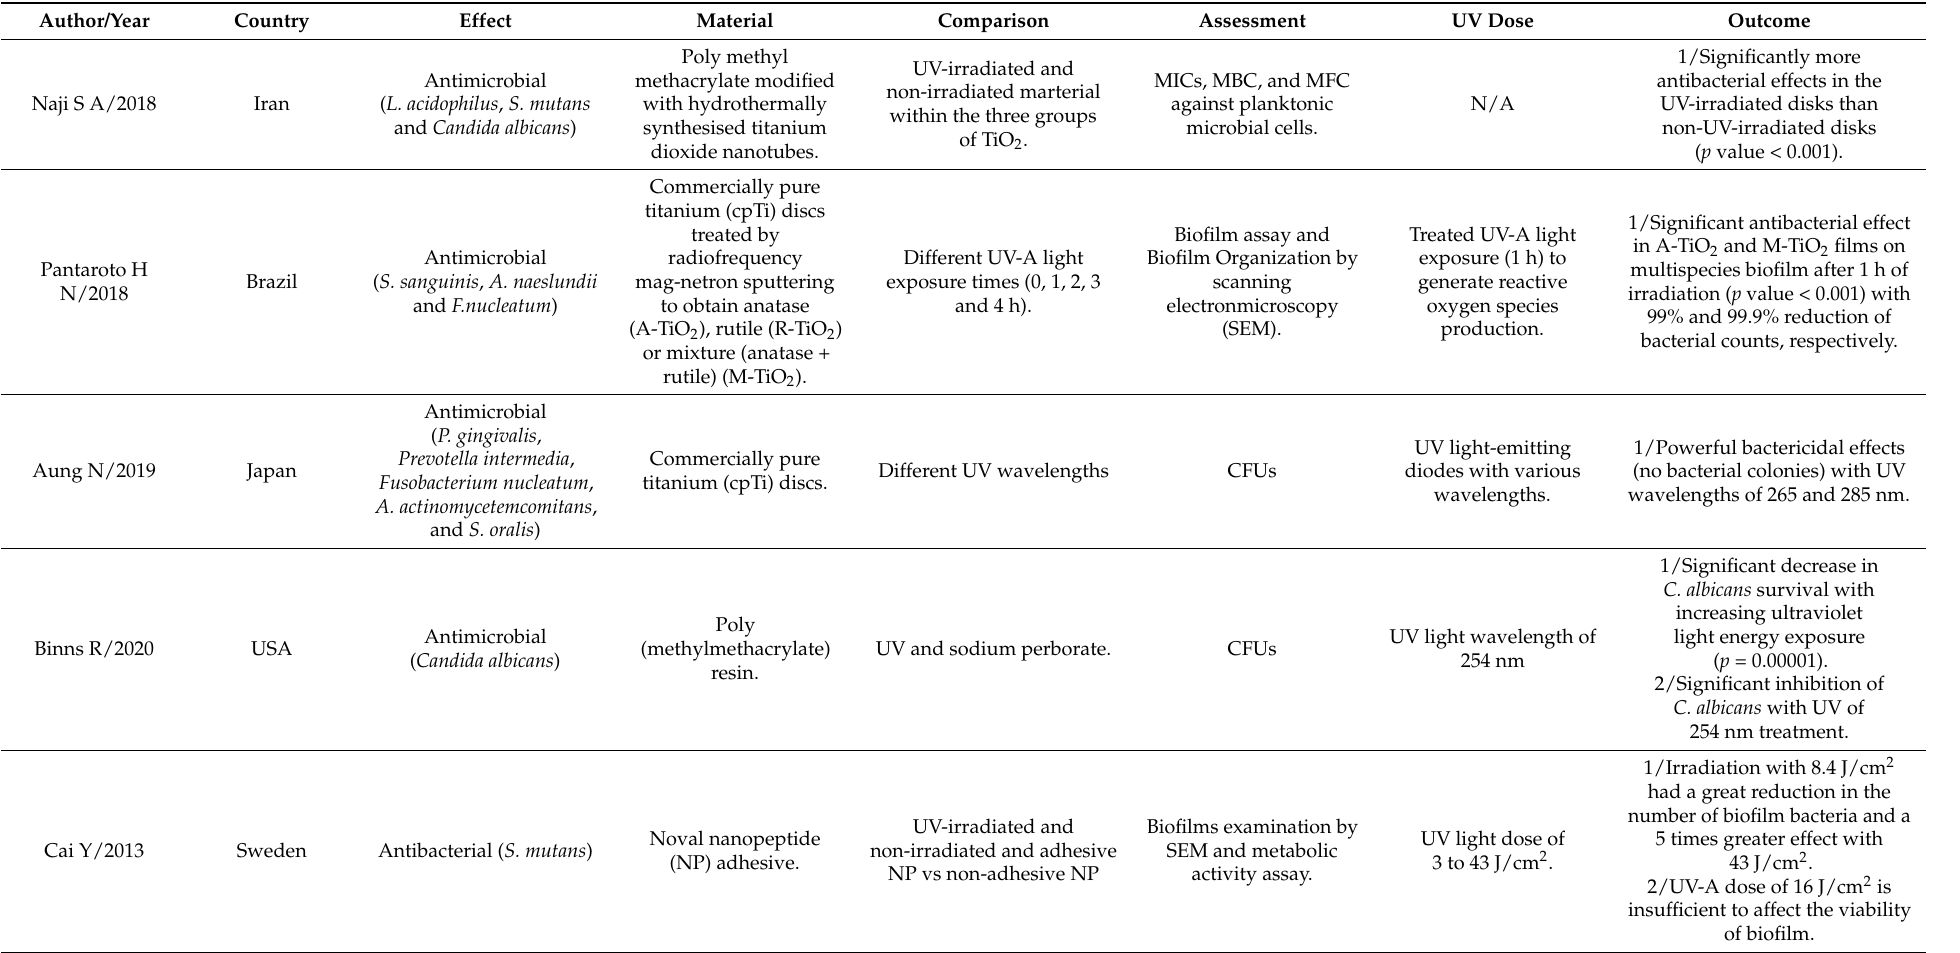
Table 1. Detailed data of included studies. Risk of bias (11 low and 5